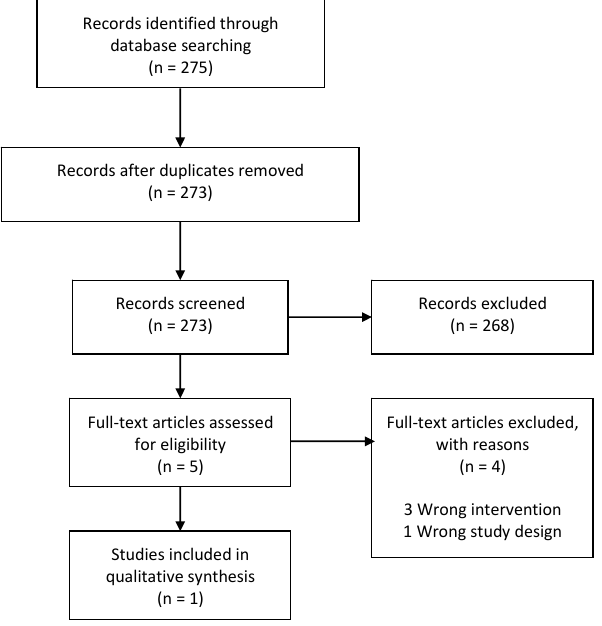
Figure 3. Flowchart of primary studies.